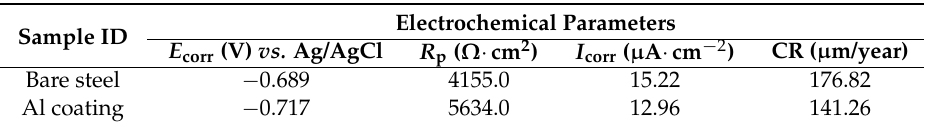
Table 4. Electrochemical parameters extracted from potentiodynamic polarization curves in the SAE J2334 solution after 1 h of